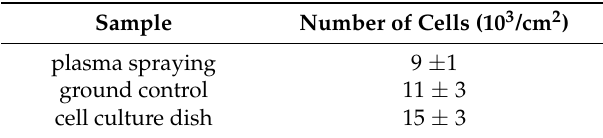
Table 2. Number of U-2 OS cells adhered on the tested materials after 24 h of